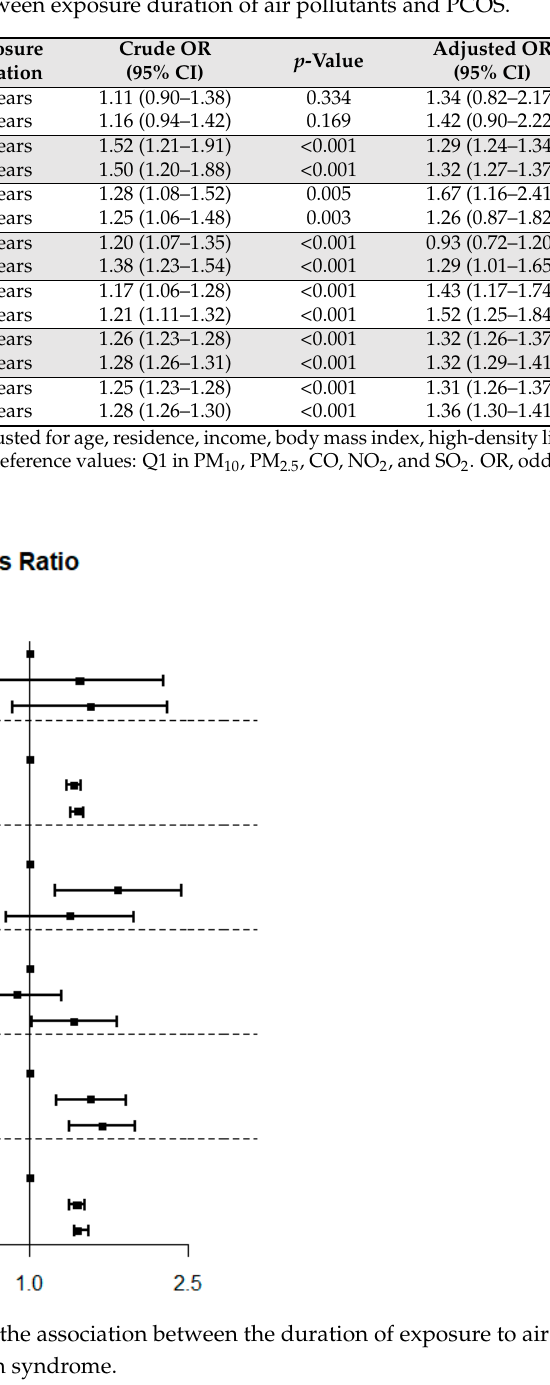
Table 3. Association between exposure duration of air pollutants and PCOS.